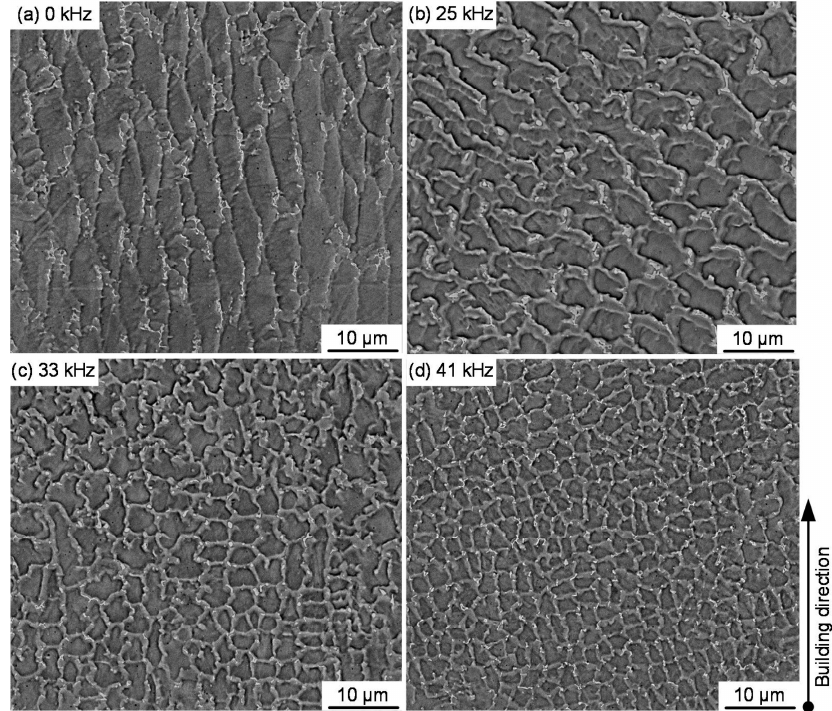
Figure 9. Effect of different ultrasonic frequencies on microstructures and grain sizes: ( a ) 0; ( b ) 25; ( c ) 33; ( d ) 41 kHz, reproduced or adapted from [43], with permission from Elsevier, 2020.